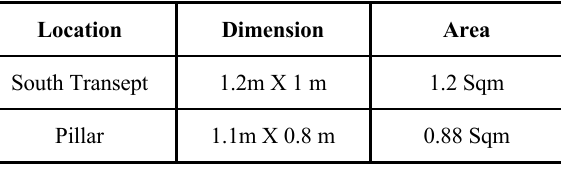
Table 1. Surveyed areas.